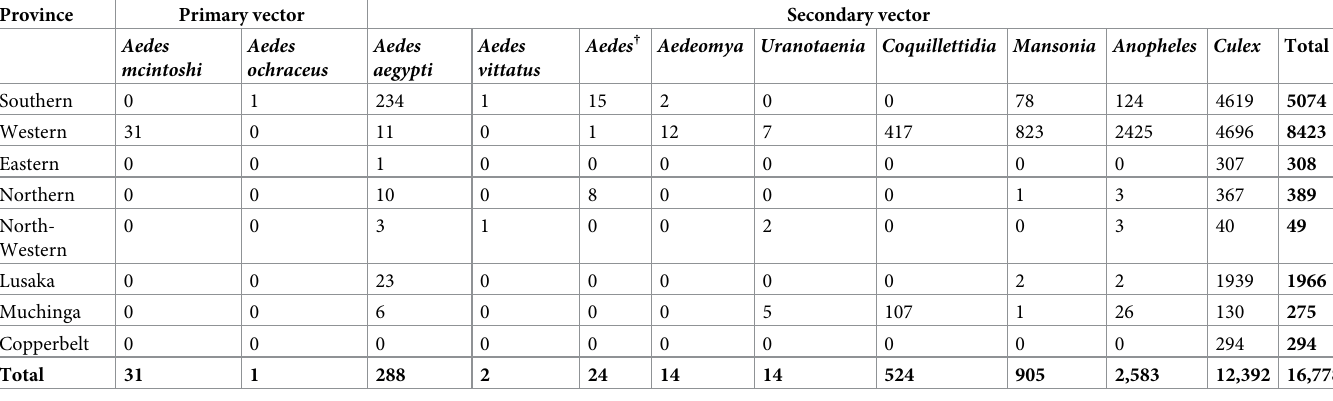
Table 3. Primary and secondary RVF vectors captured by province in Zambia.